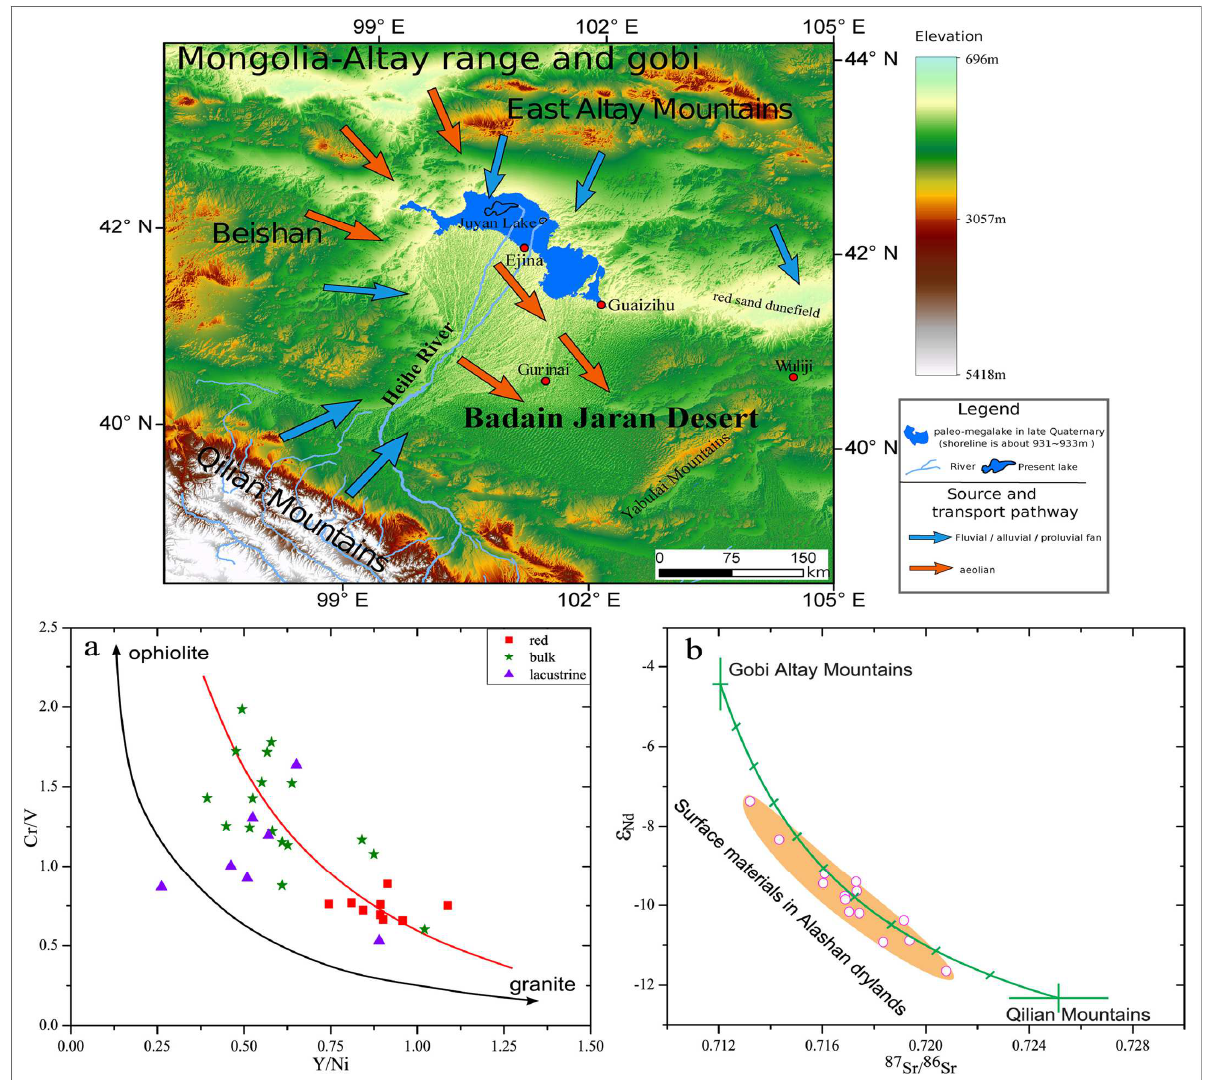
Figure 13. Source areas and source materials of dune sand in sandy deserts of the Alashan Plateau (revised from [24]). Schematic graph of source and transport pathways of sands in the Badanjilin Desert showing source contribution from Qilian Mountains and Gobi Altay Mountains via fluvial- alluvial and aeolian processes ( upper figure ). Dried palaeo-megalake beds (blue-shaded areas) are potentially direct sediment sources for aeolian transportation. Binary plots of ( a ) Y/Ni vs. Cr/V for different samples, mixing line between ophiolite and granite end-members indicating relative proportion of ultramafic and felsic rocks in the source regions. The plot of Y/Ni vs. Cr/V showing source materials from the Qilian Mountains tend to have higher ultramafic components than from Gobi Altay Mountains and implying a mixture of binary sources from Qilian Mountains and Gobi Altay Mountains for the Badanjilin Desert sands; ( b ) 87 Sr/ 86 Sr vs. ε Nd (modified from [132,133]), mixing line between Qilian Mountains and Gobi Altay Mountains